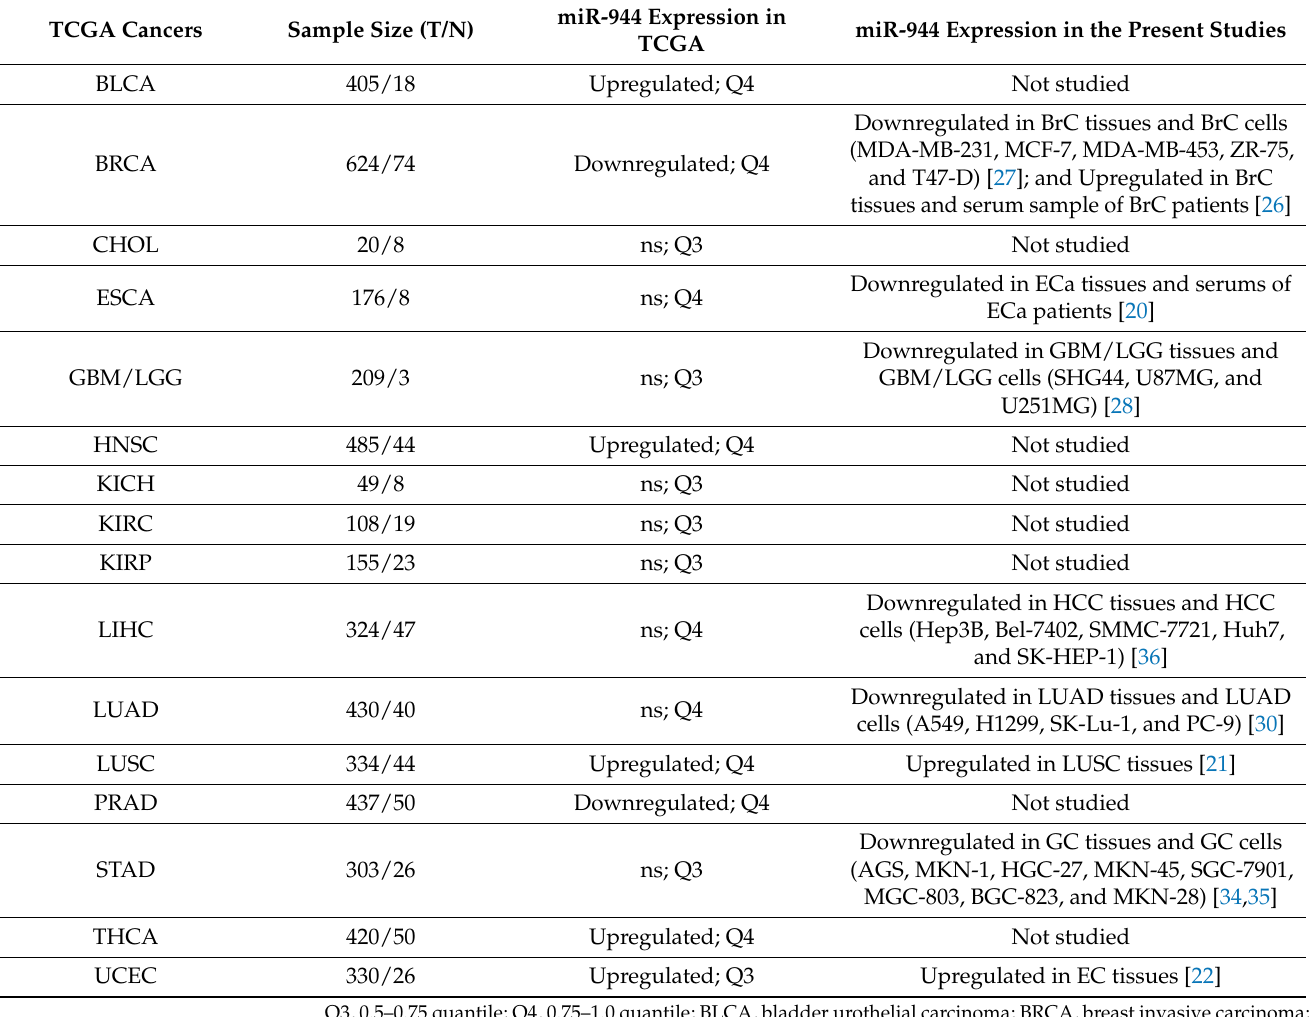
Table 2. Comparison of miR-944 in TCGA dataset with existing